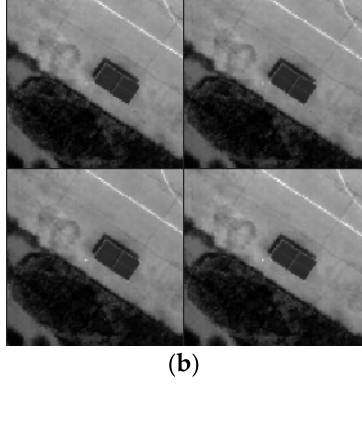
Figure 4. Cont . Figure 4.